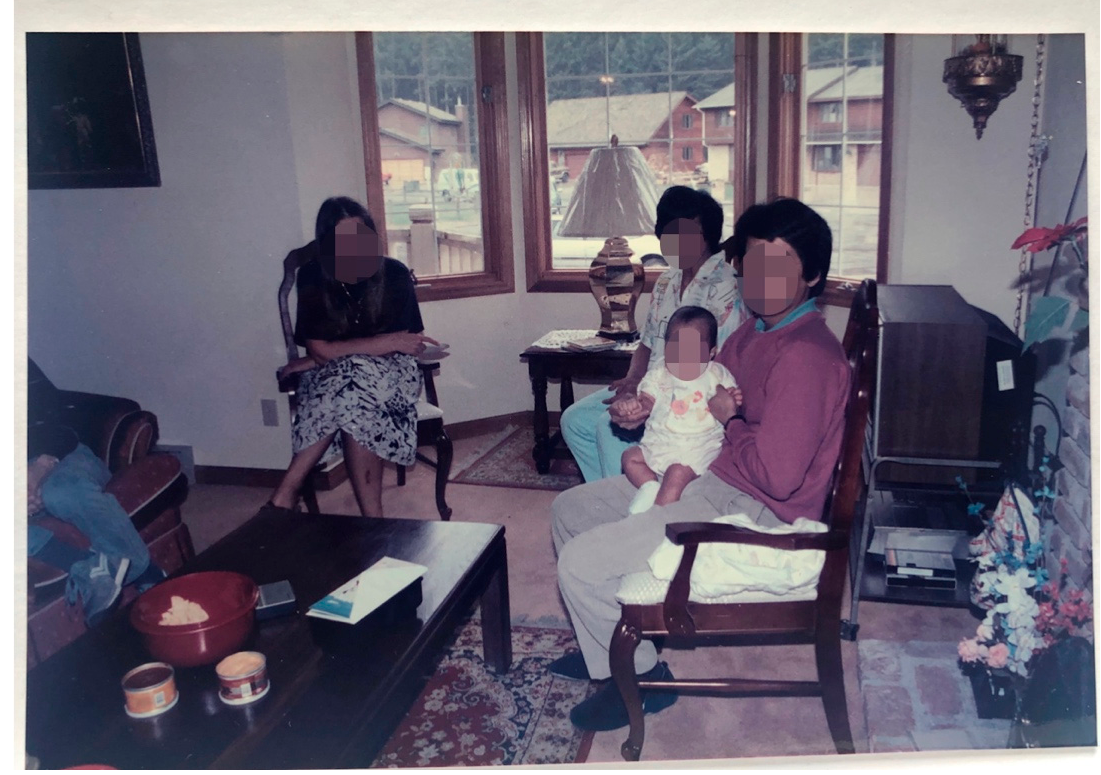
Figure 4. Ana’s photo.